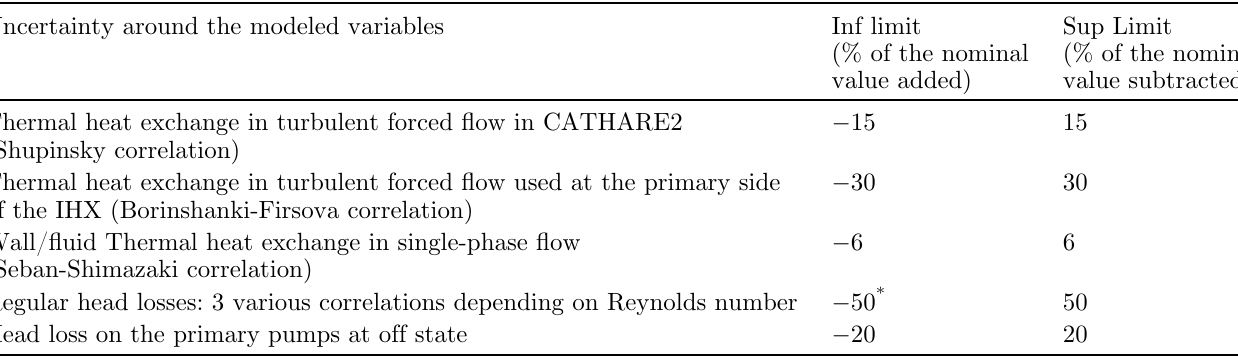
Table 7. Main model parameters uncertainties (2/2) following a uniform law. Uncertainty around the modeled